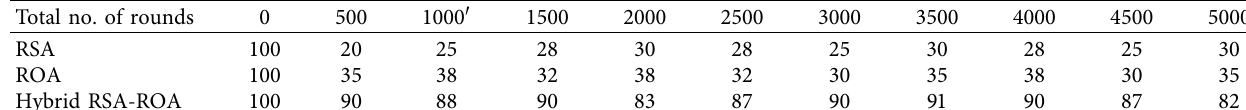
Table 7: Number of live nodes for proposed network 1.